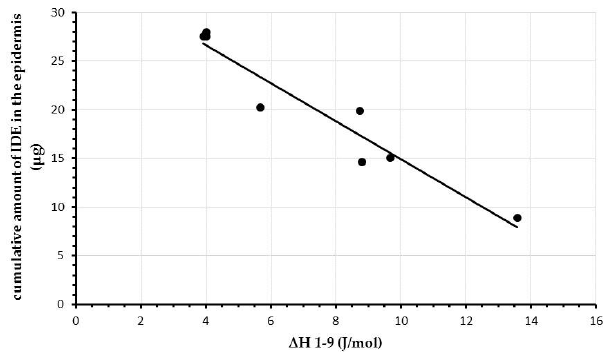
Figure 6. Relationship between the cumulative amounts of IDE penetrated in the epidermis and ΔH differences (ΔH1–9) between the first and the last scan. Each data represents the mean of three different experiments. Standard deviations (S.D.) were omitted for clarity and were within 5% for ΔH values.